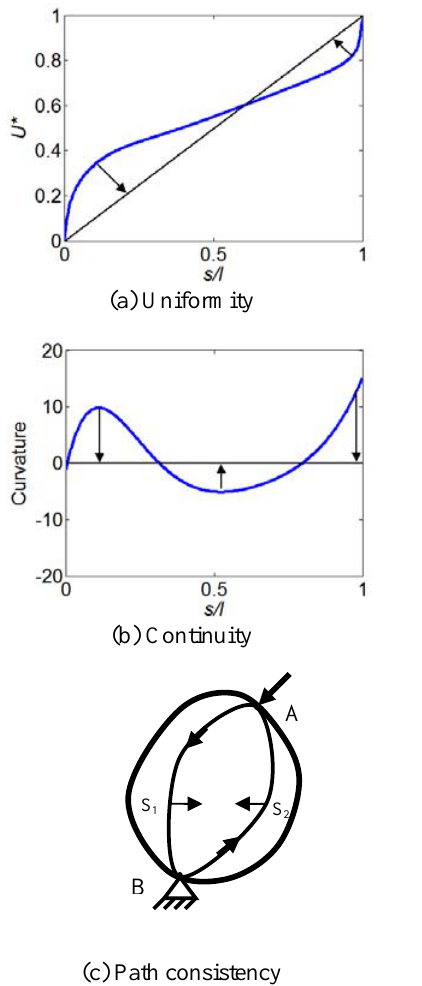
Fig. 11. Conditions that need to be satisfied to achieve a